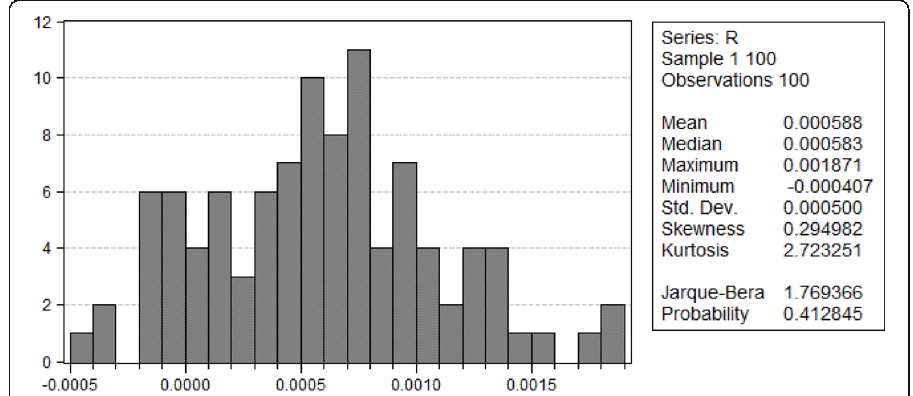
Fig. 4 The distribution and summary statistics of the average simulated return for the ARMA (1,1) process. We use R to denote the average value of the simulated returns. The distribution of R is shown in the left, and the summary statistics are listed in the